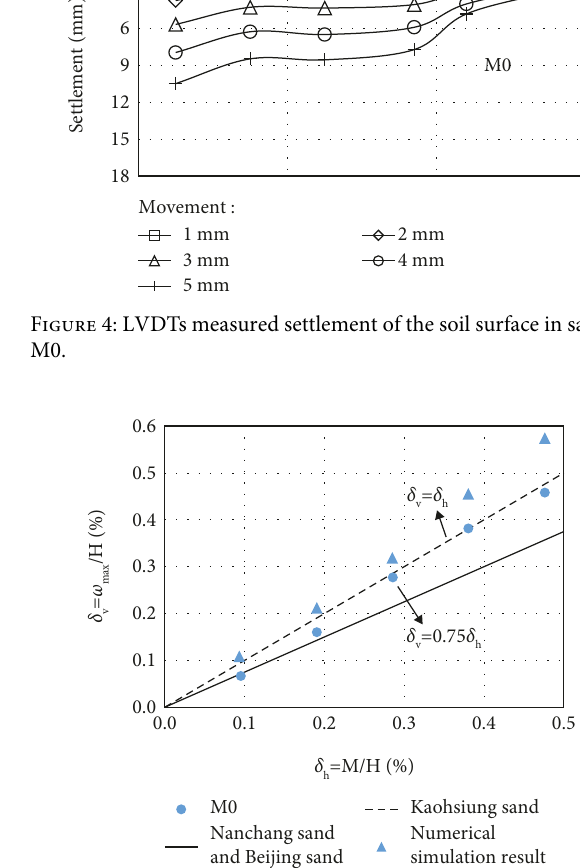
Figure 5: Relationship of maximum ground settlements with retaining wall movement in M0, data for Kaohsiung sand from Hsiung [5], data for Nanchang sand from Wang et al. [16], and Beijing sand from Wu et al. [18].